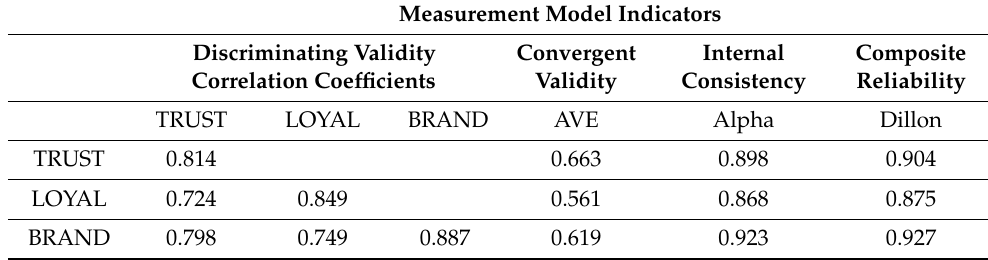
Table 2. Measurement model